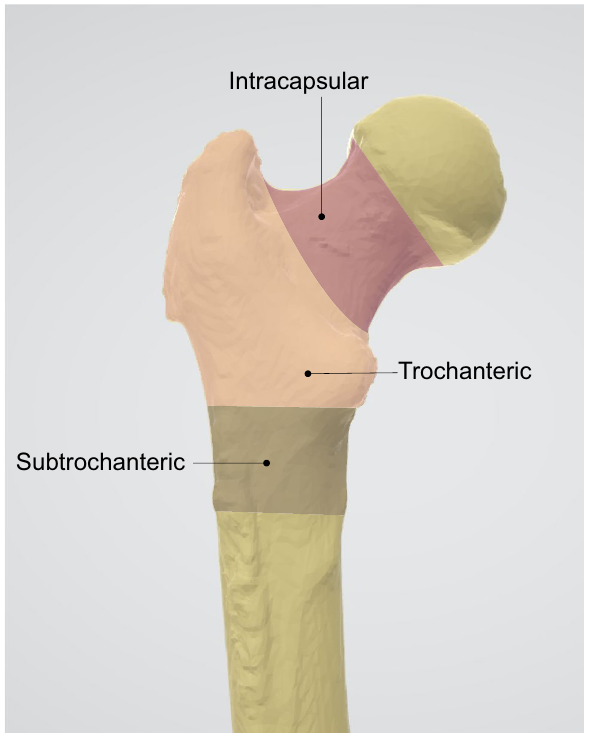
Figure 1. Hip fracture